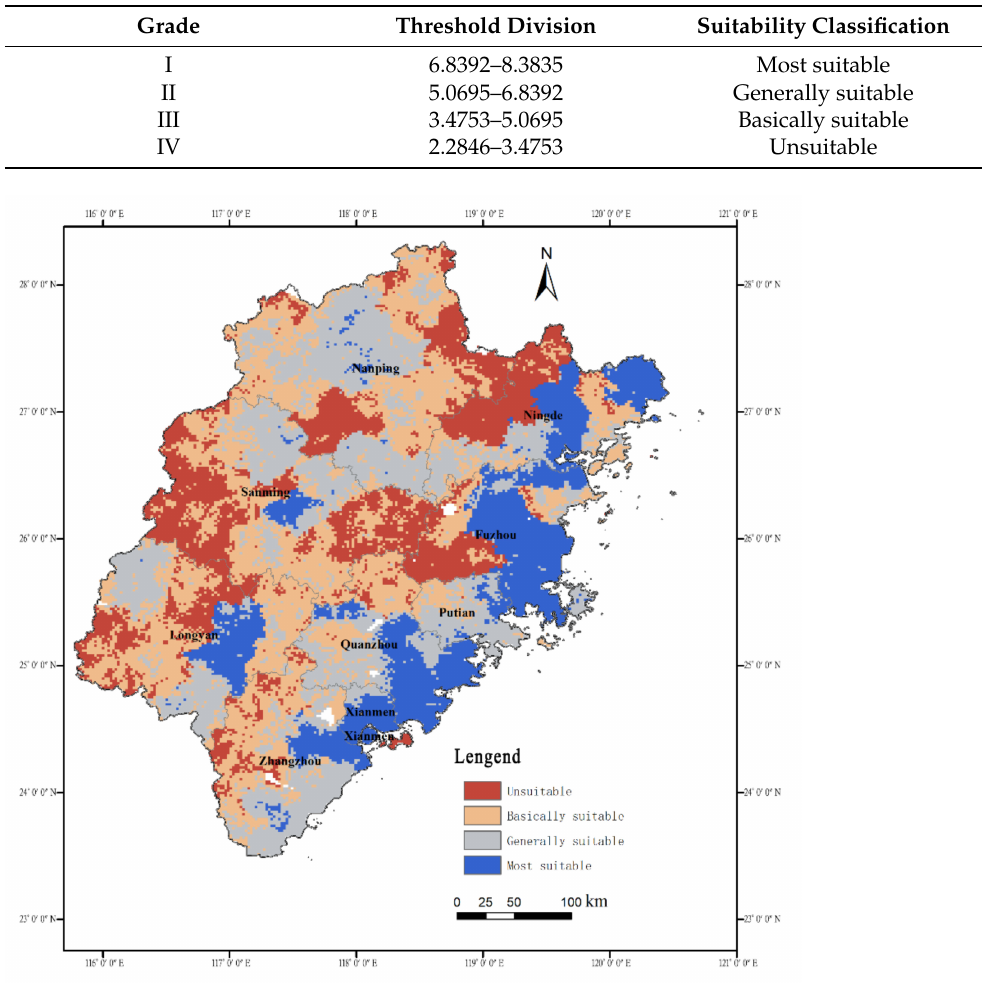
Table 4. Classification standard for suitability evaluation of ethnic minority villages in Fujian Province.